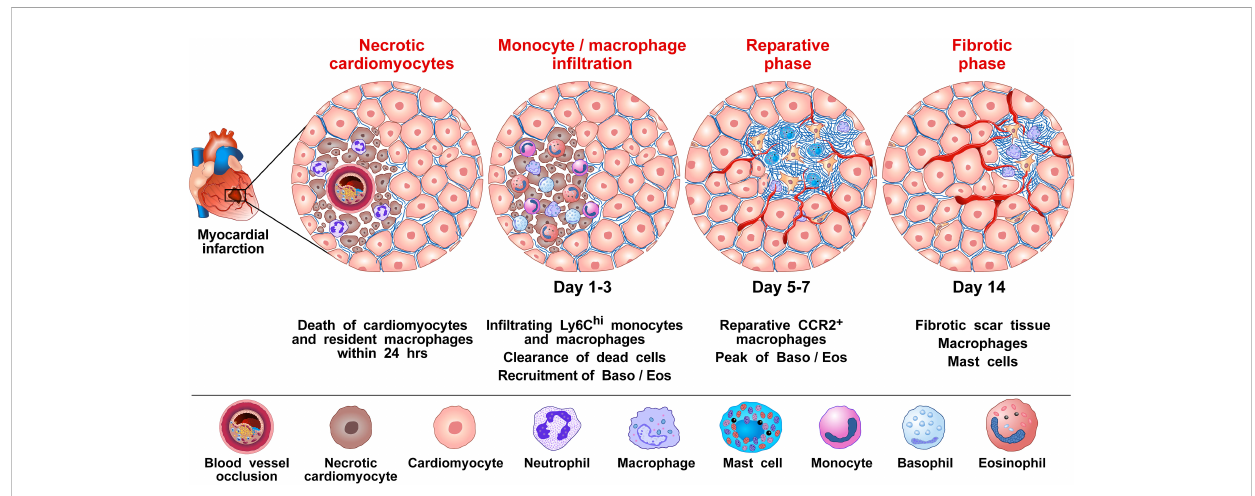
FIGURE 1 Proposed mechanism by which basophils in fl uence the in fl ammatory response to promote wound healing and tissue repair following myocardial infarction (MI). MI is caused by the rupture of an atherosclerotic plaque causing the occlusion of a coronary artery, which then results in cardiac tissue damage due to ischemia (90). It has been shown in mice that several immune cells [e.g., monocytes/macrophages, neutrophils, dendritic cells (DCs), B and T cells, and natural killer (NK) cells, basophils and eosinophils in fi ltrate the heart after experimental MI (70, 97, 110). For basophils,